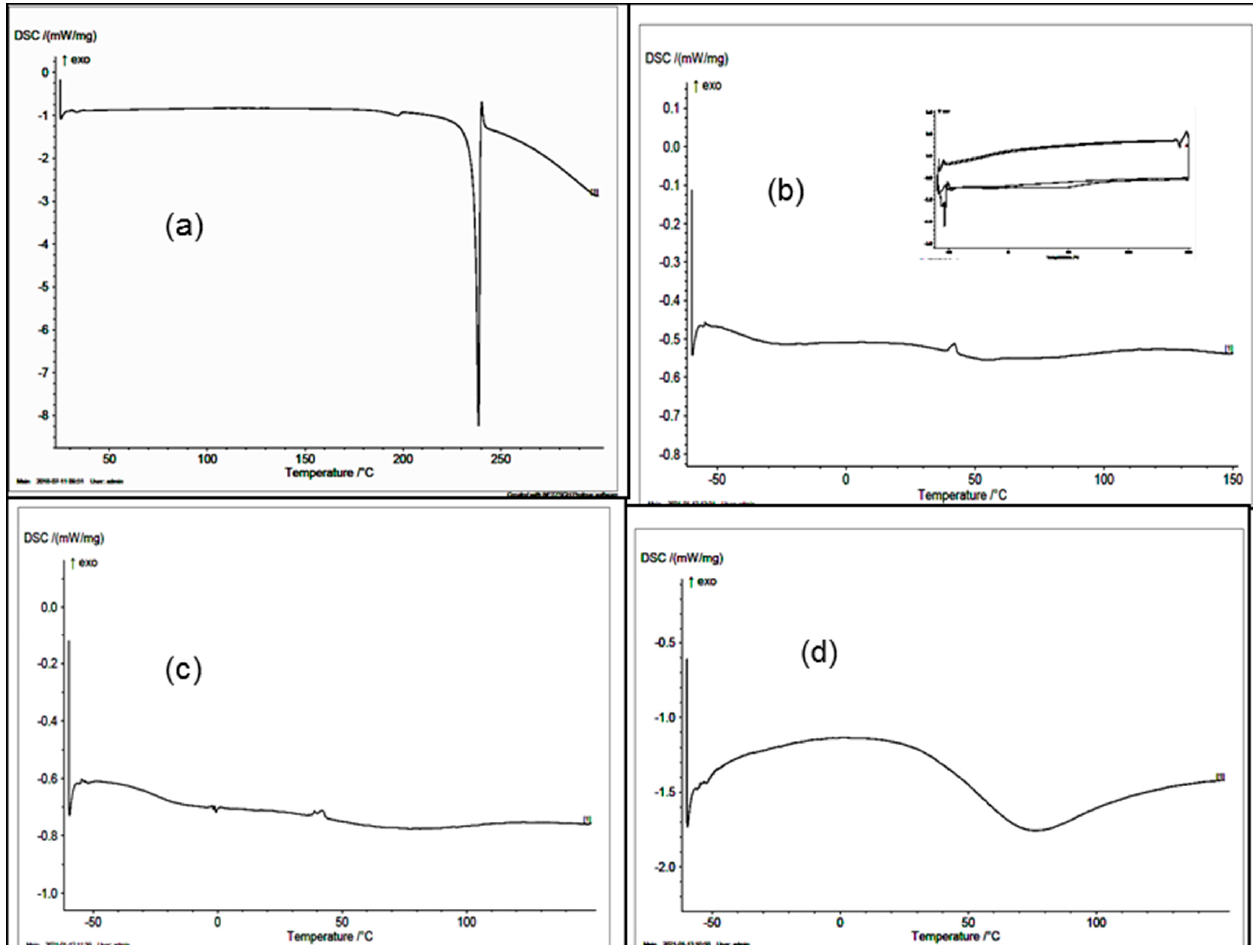
Figure 6. DSC thermogram of ( a ) blocked TDI, ( b ) PU-TDI-PPG-1000 (inset: two cycles), ( c ) PU-TDI-PPG-2000 and ( d ) PU-PPG-3000.